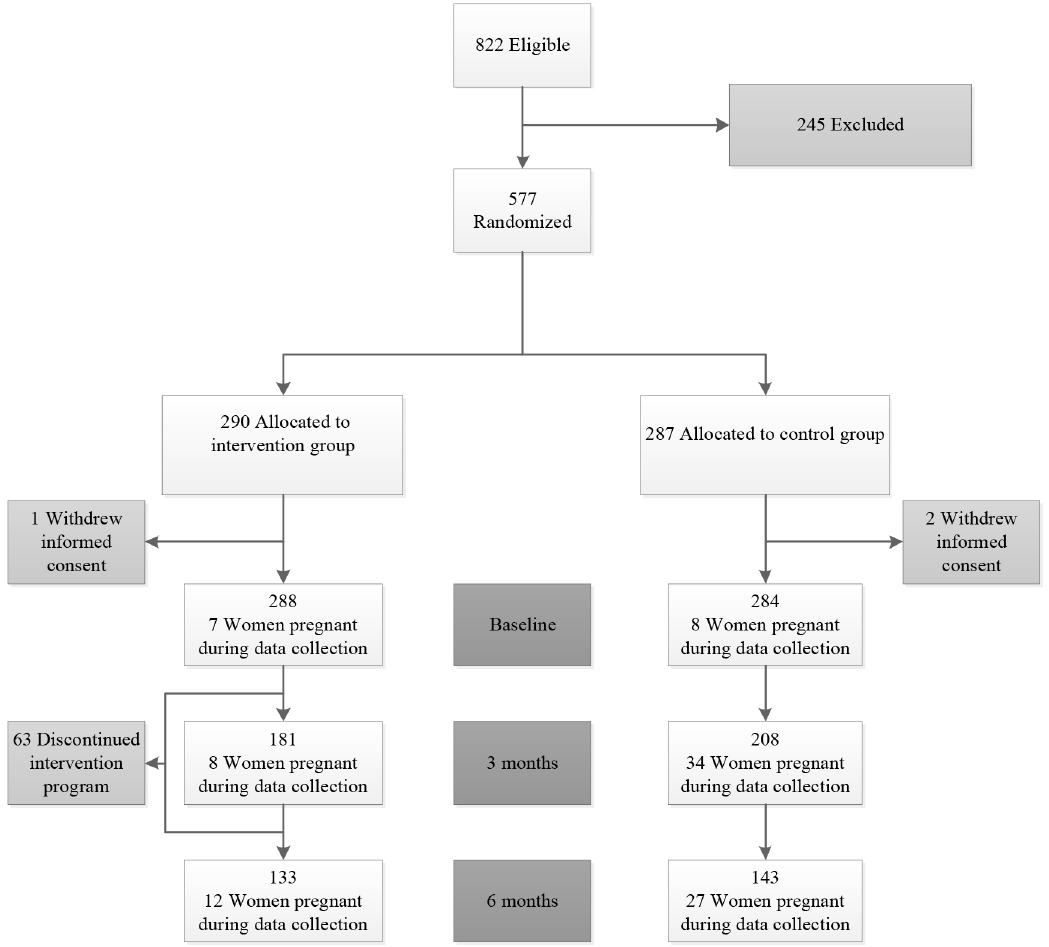
Fig 1. Flowchart of participants. Baseline values are based on number of participants for whom BMI was available. Due to intercurrent pregnancies, or reaching the goal of the intervention prior to 24 weeks (BMI < 29 kg/m2 or > 5% weight loss) or because participants did not attend the hospital visit, the numbers of participants are decreasing over